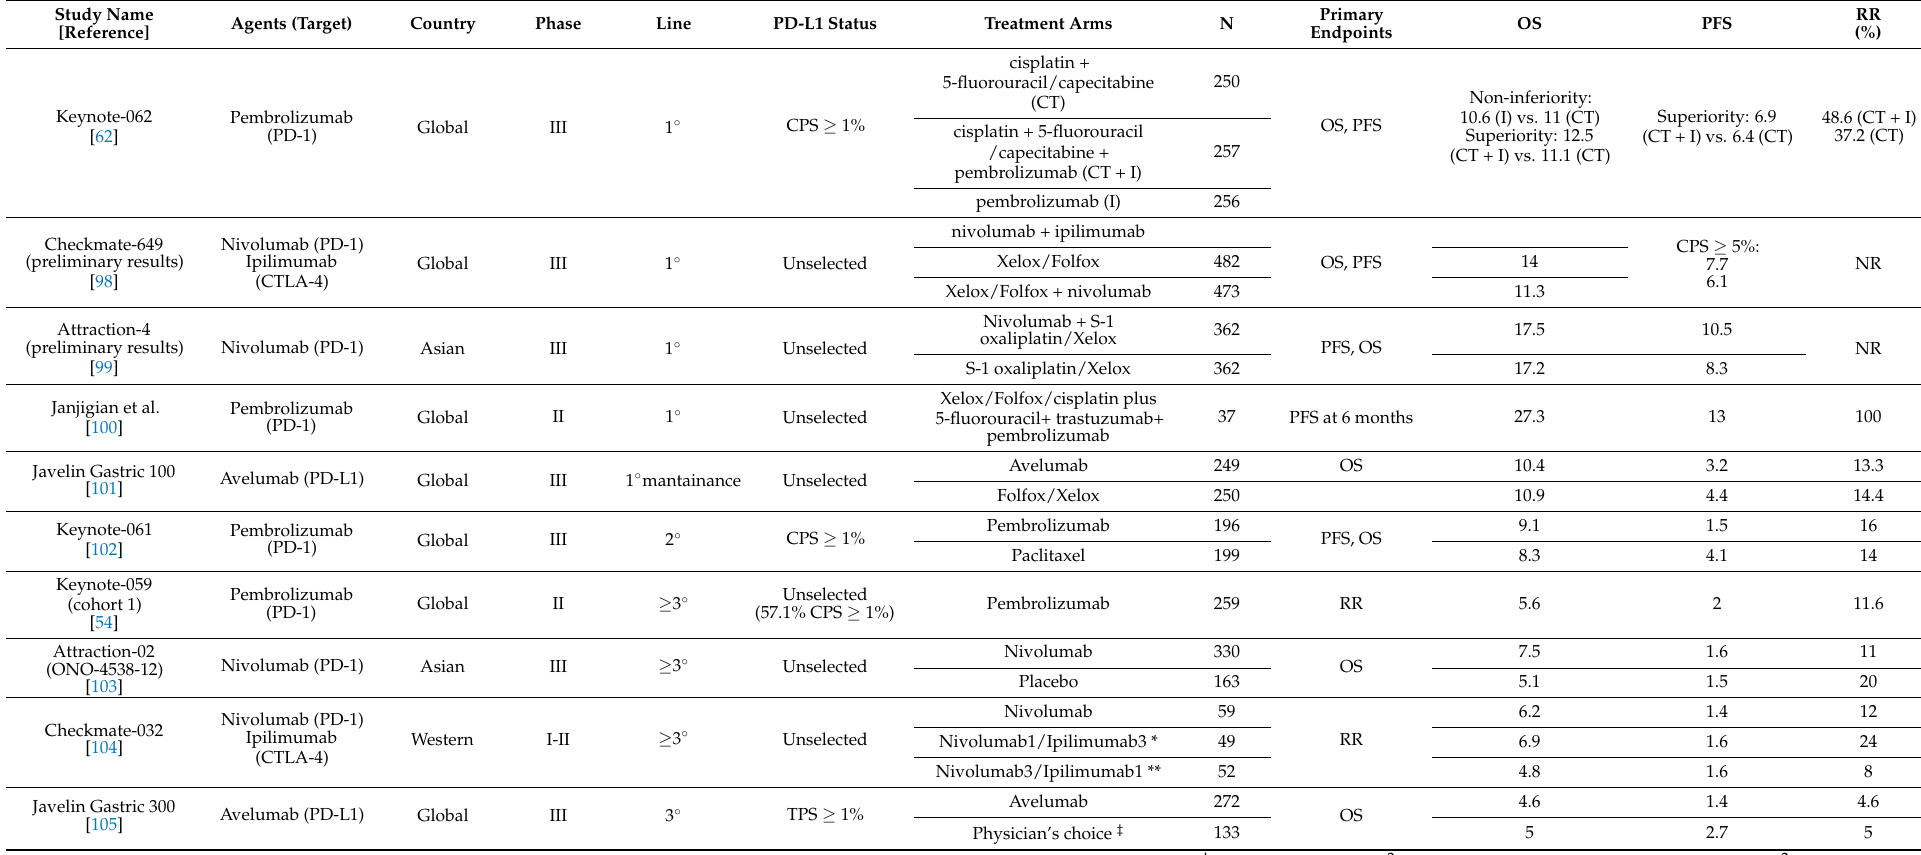
Table 3. List of major completed phase II-III trials with immune checkpoint inhibitors in metastatic gastric